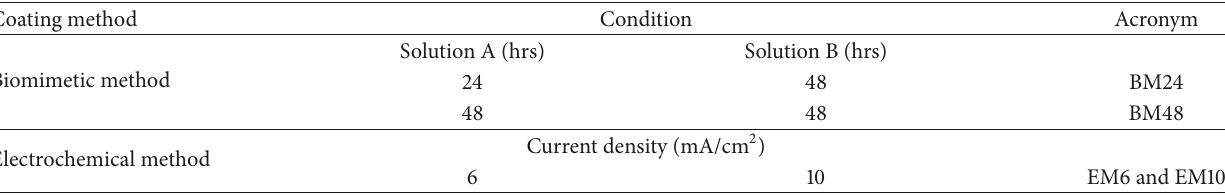
Table 2: Scaffold formulations in terms of coating technique and